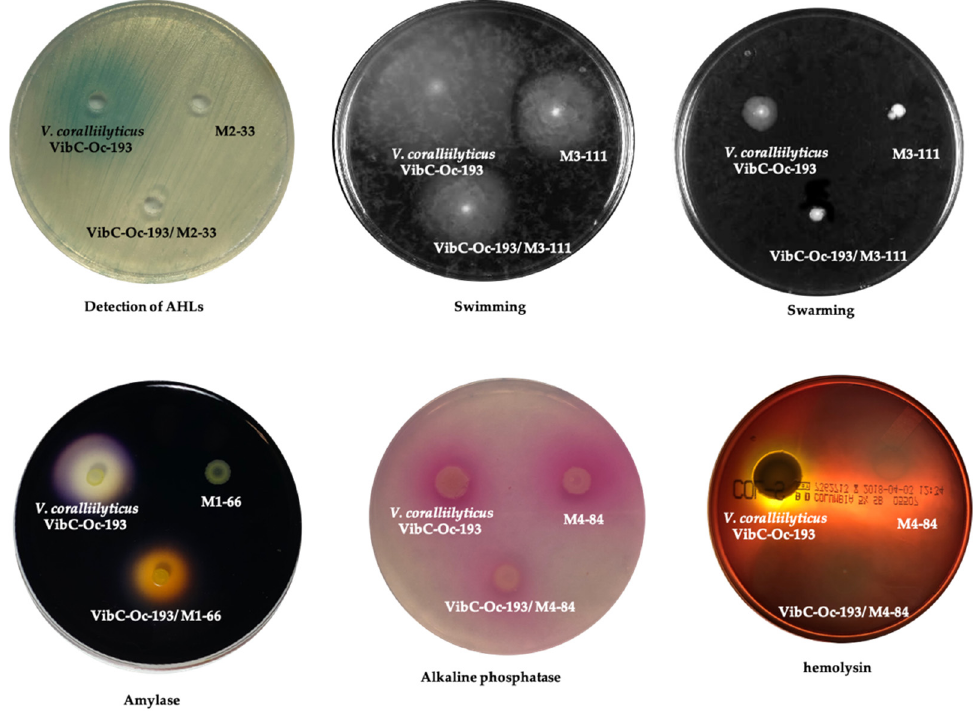
Figure 2. Detection of AHLs and phenotypes (enzymatic activities and motility) in the monocultures and co-cultures of AHL-degrading strains and the pathogen V. corallilyticus VibC-Oc-193. A. tumefaciens NTL4 (pZLR4) was used as biosensor strain to detect AHLs.